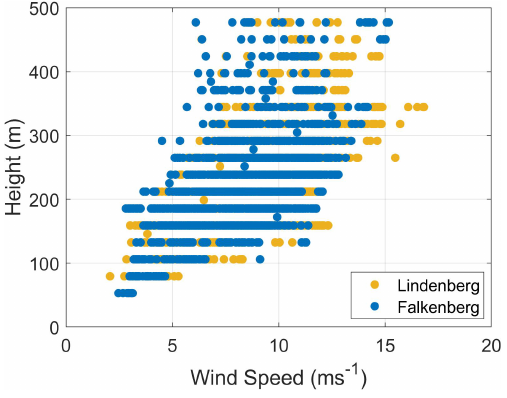
Figure 6. NLLJ core height against core wind speed color-coded for the two sites.